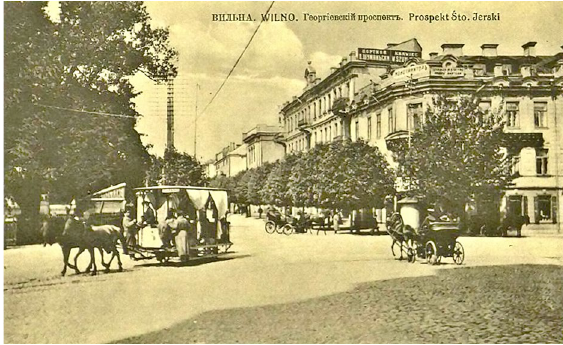
Fig. 3. The konkė coach at the beginning of the Georgijevsky prospect (now Gedimino pr